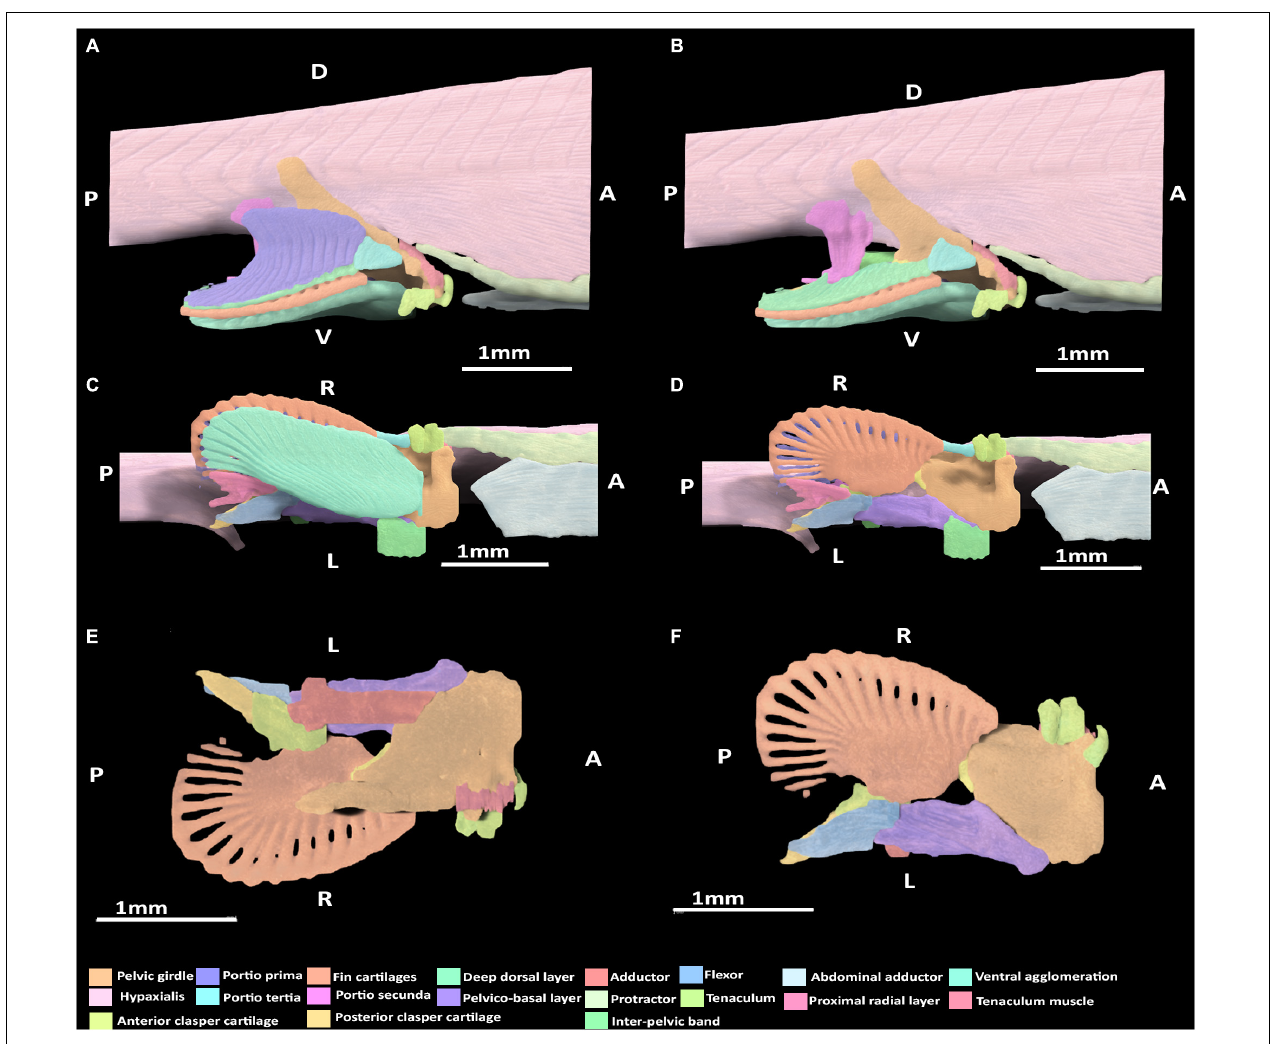
FIGURE 5 | 3D model of the right pelvic musculature of a stage 32 male elephant shark ( Callorhinchus milii ) embryo. (A) Lateral view of musculature, (B) lateral view with the portio prima removed, (C) ventral view of musculature, (D) ventral view with the superficial ventral layer removed, (E) dorsal view of the reproductive musculature, (F) ventral view of the reproductive musculature. Anatomical planes and position indicated by lettering: A, Anterior; P, Posterior; D, Dorsal; R, Right; L,